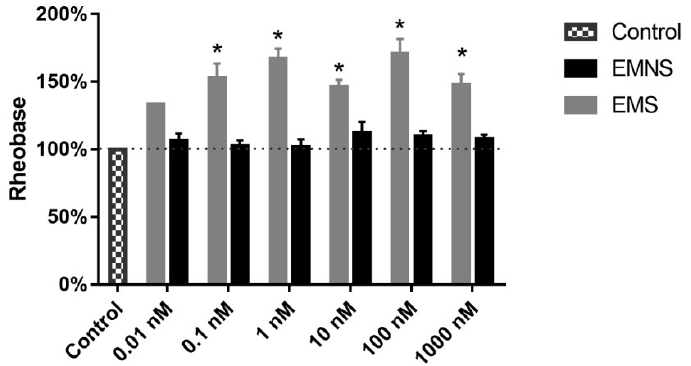
Figure 2. Effect of melatonin on the rheobase of N inf excitability melatonin sensitive (EMS) and excitability melatonin not sensitive (EMNS) cells. These data, expressed in normalized values, are presented as means ± SEM and rheobase absolute control values are found in Table 1. The number of experiments of N inf EMS neurons at concentrations of 0.01, 0.1, 1.0, 10.0, 100.0, and 1000.0 nM were 1, 4, 6, 10, 3, and, 10, respectively. The number of experiments of N inf EMNS neurons at concentrations of 0.01, 0,1, 1.0, 10.0, 100.0, and 1000.0 nM were 13, 7, 12, 15, 10, and 18, respectively. Ordinate, percentage of own control value. Abscissa, melatonin concentration (control, only vehicle). The symbol * indicates statistical difference compared to control ( p < 0.05, paired Student’s t -test).